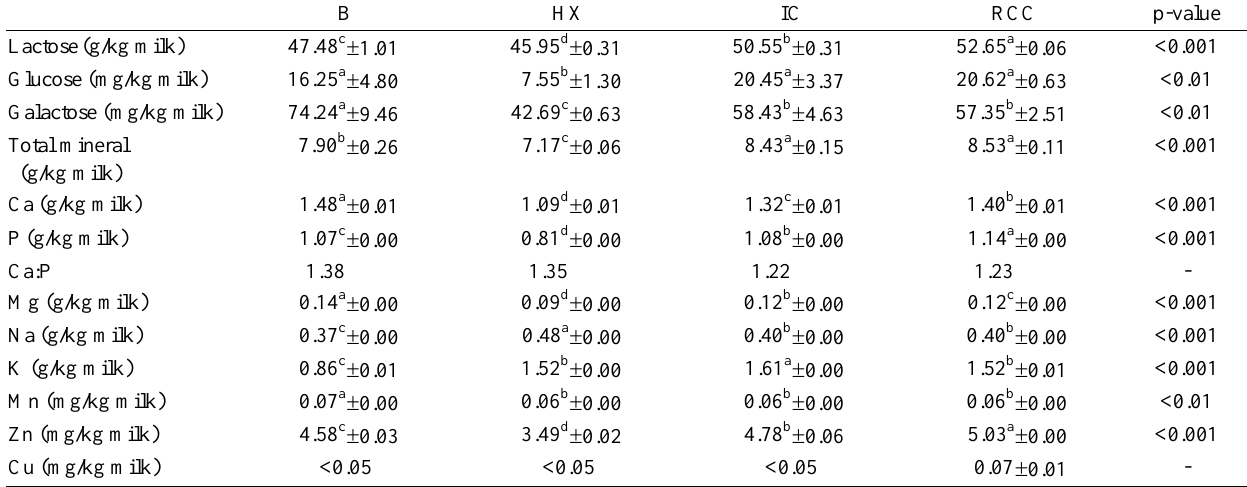
Table 6. Content of carbohydrates and minerals in buffalo (B), Holstein cross (HX), Indigenous cattle (IC) and Red Chittagong Cattle (RCC)